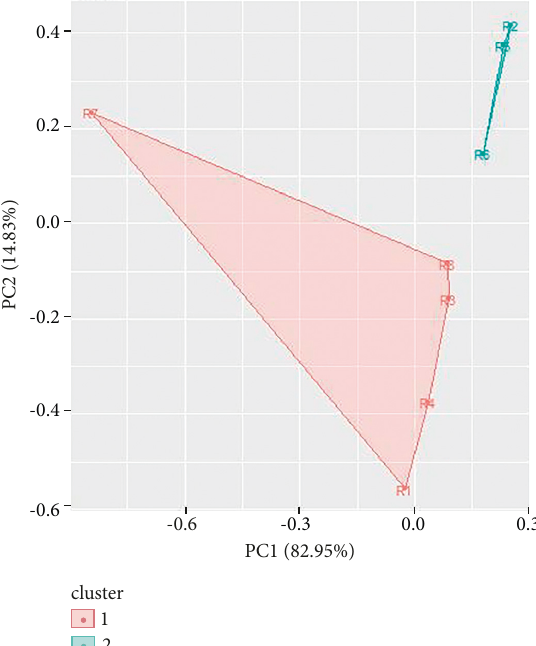
Figure 13: Cluster analysis for FTIR spectroscopy data for blue ballpoint pen inks.